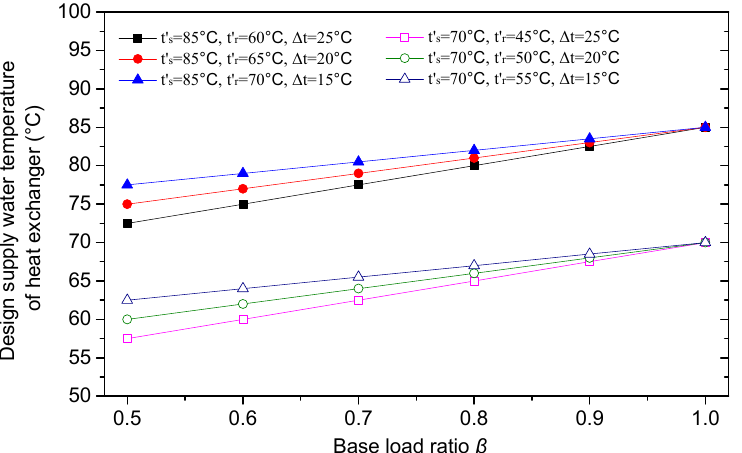
) with di ff erent s , hr